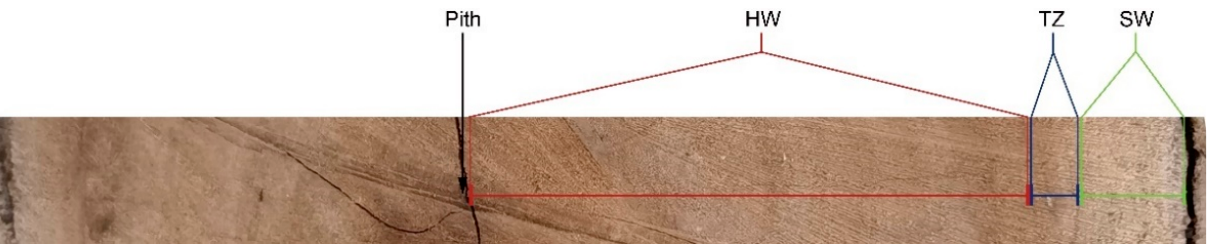
Figure 8. The sampling locations of different tissues of the P. hui wood strips. SW, sapwood; TZ, transition zone; and HW, heartwood.